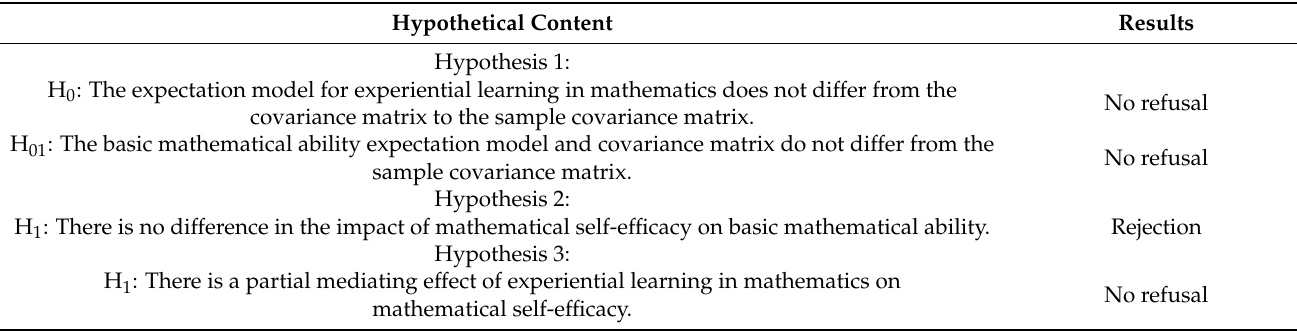
Table 12. Structural model assumptions and